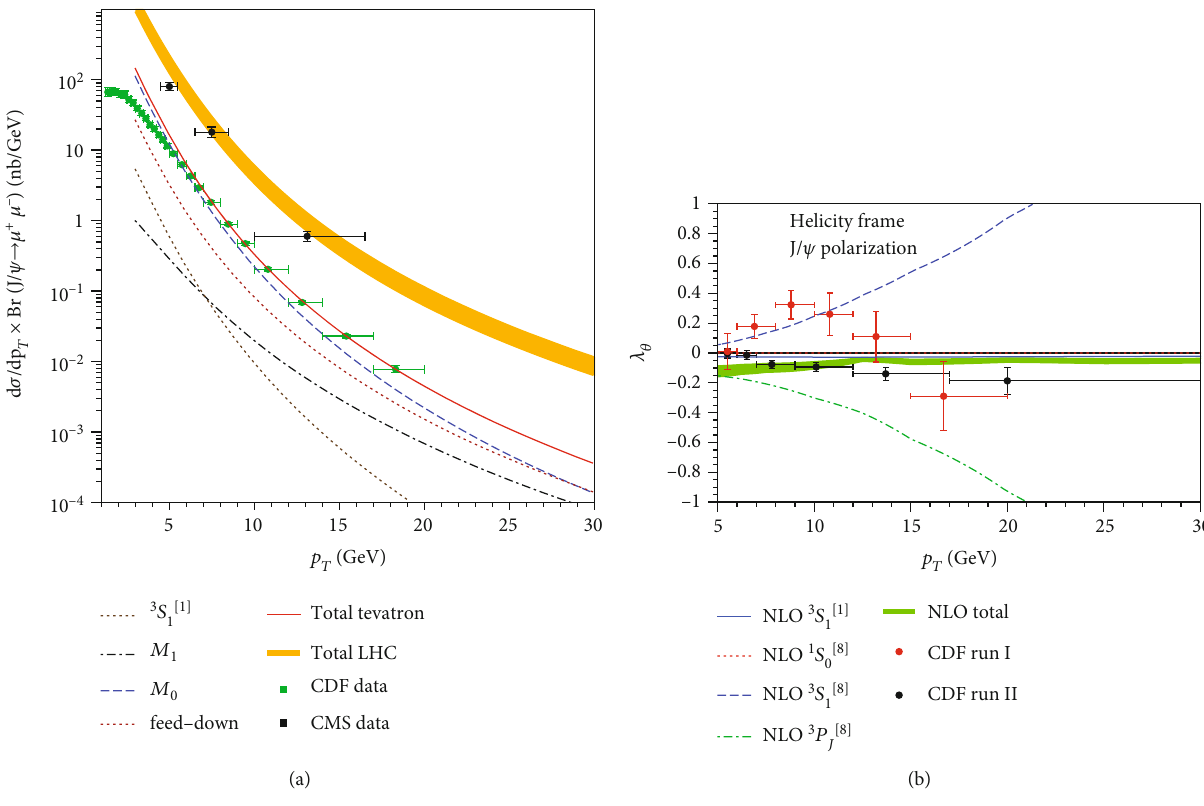
Figure 1: Comparison of NLO NRQCD calculations with prompt J / ψ data. (a) The p and the LHC. (b) NLO NRQCD prediction for the polarization of J / ψ production at the Tevatron. Figures taken from Refs. [75,